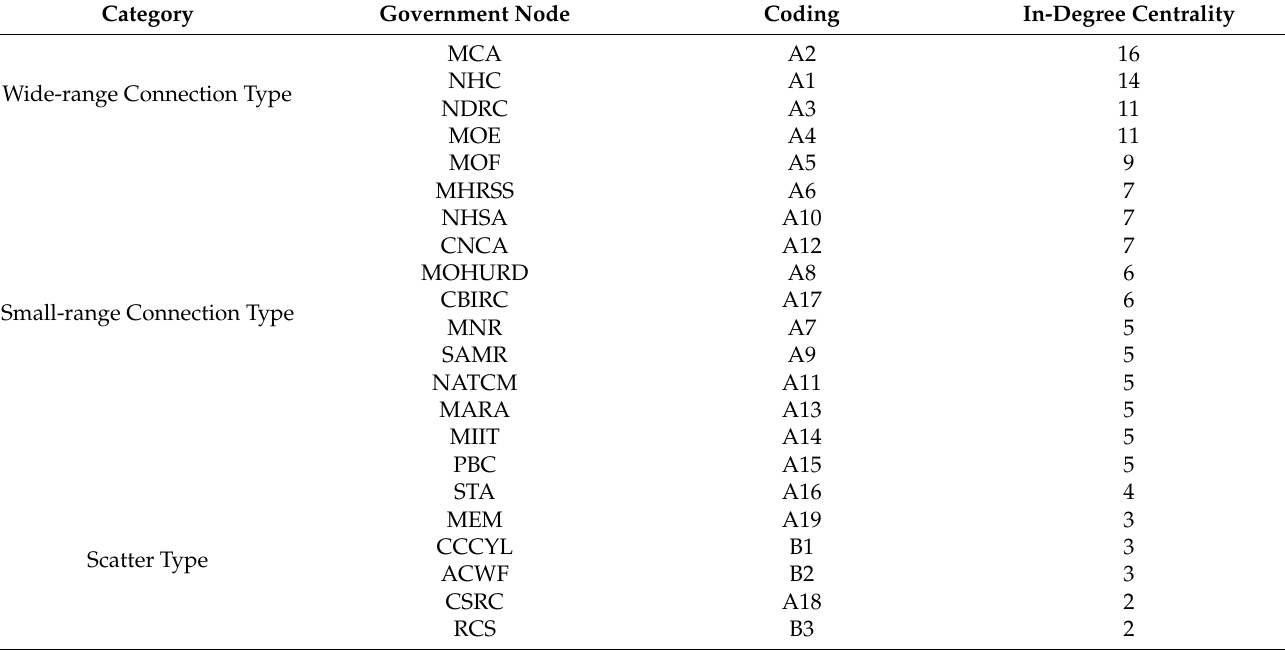
Table 3. The in-degree centrality values of different